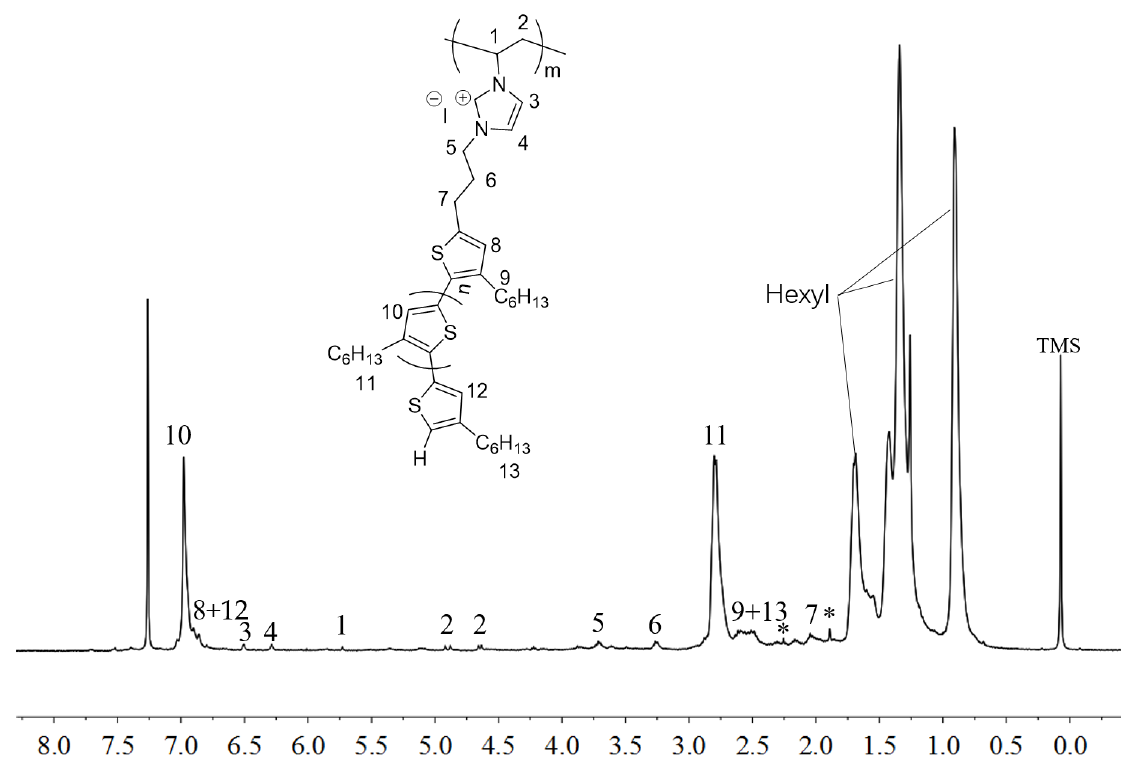
Figure 6. 1 H-NMR (400 MHz, CDCl 3 ) spectrum of brush polymer P[P3HT-(CH 2 ) 3 -VIM]. Peaks marked * correspond to residual NMR solvent